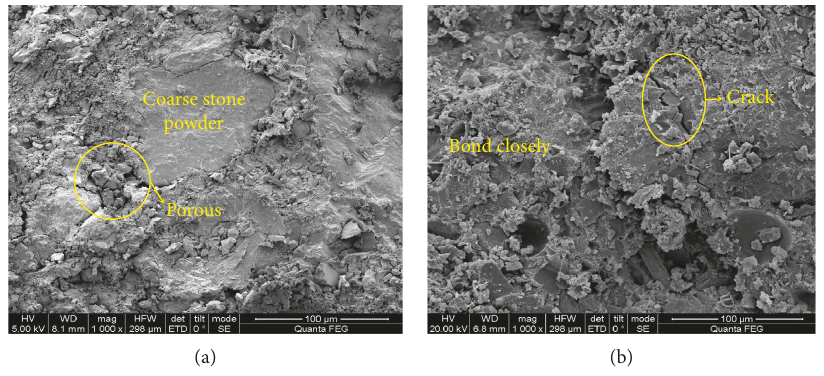
Figure 10: SEM micrographs: the ratio of resin to stone powder is (a) 1 :4 (A1) and (b) 1:5.5